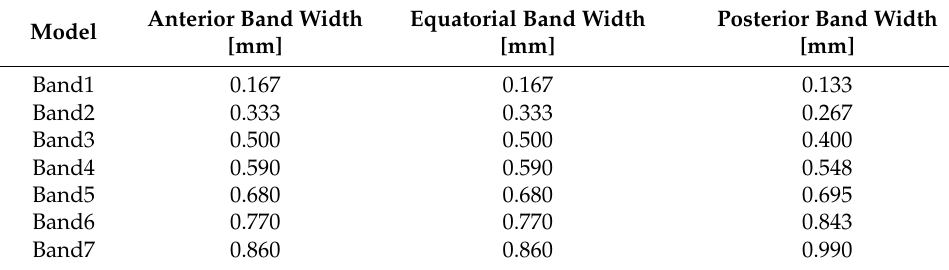
Table 2. Band widths of the capsular anchorage regions for different model